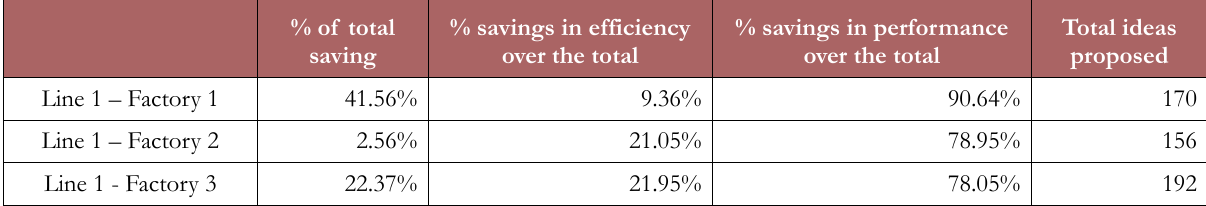
Table 1. Summary of the economic